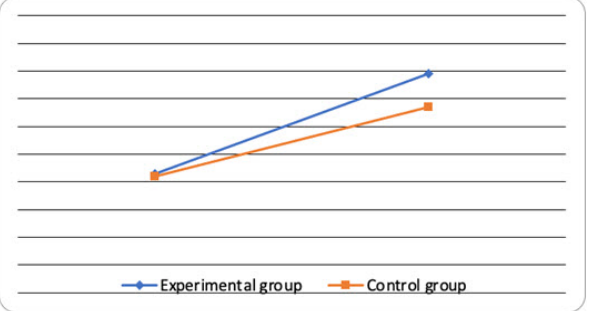
Chart 1. Comparison of the average values of practical English knowledge of the experimental and control